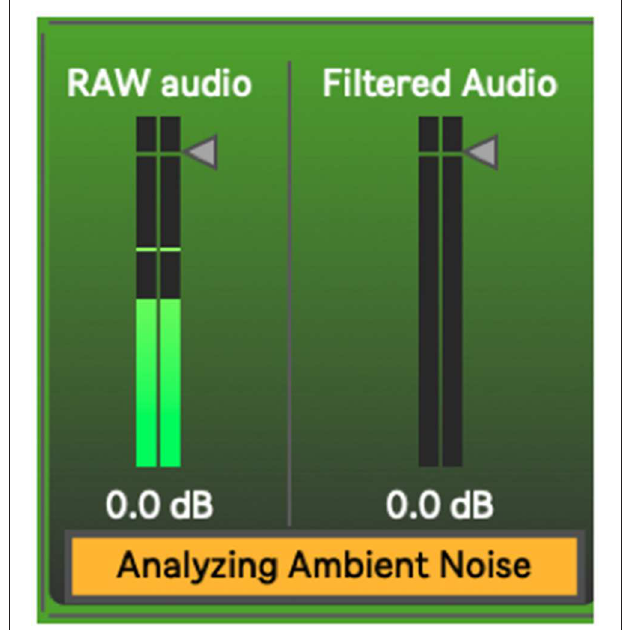
FIGURE 7 | Sig2 ∼ ’s noise floor elimination apparatus at work.